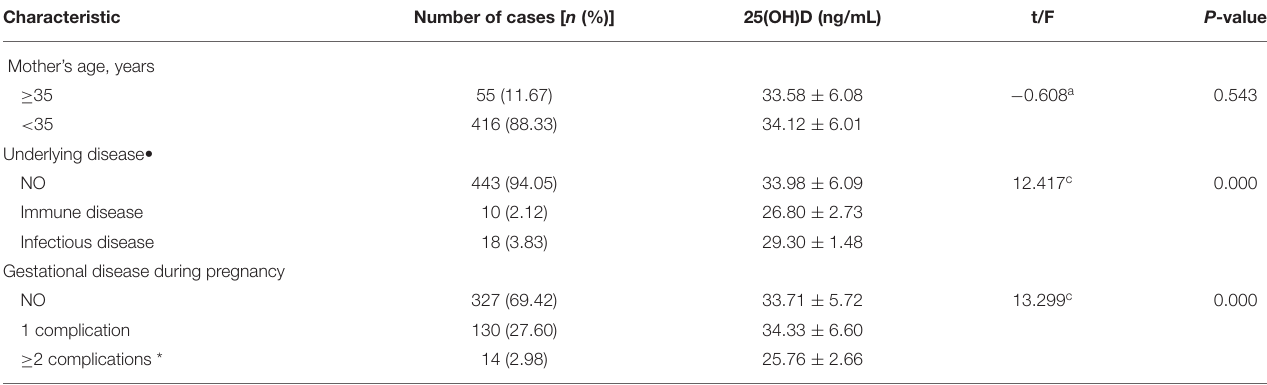
TABLE 2 | Maternal characteristics.